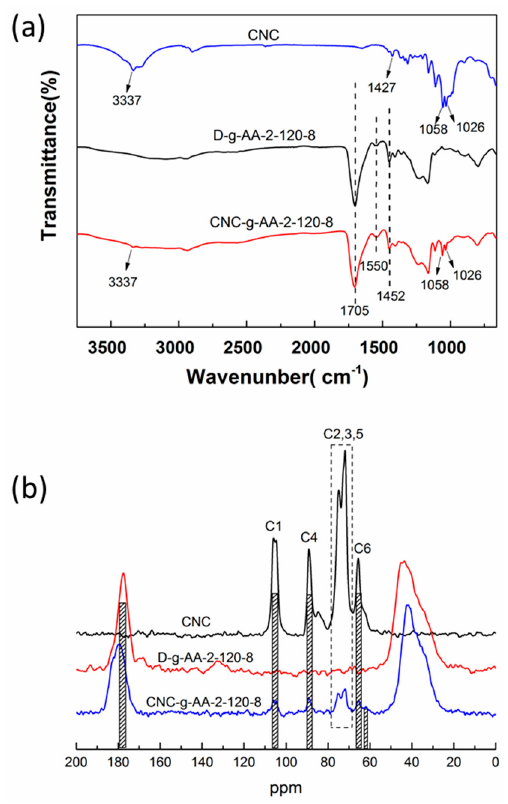
Figure 3. FT-IR ( a ) and 13 C NMR ( b ) spectra of CNC, D-g-AA-2-120-8 aerogels and CNCs-g-AA-2-120-8 aerogels.